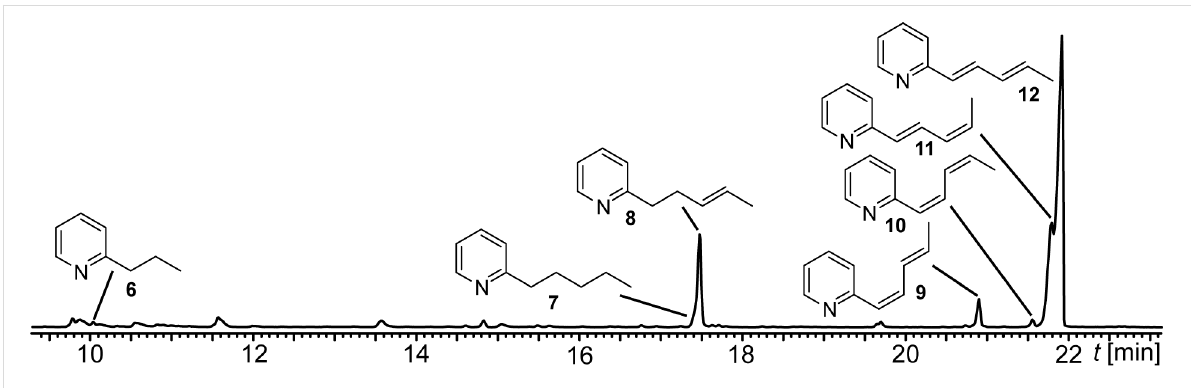
Figure 2: Part of the total ion chromatogram of the headspace extract of Streptomyces sp. FORM5 with the structures of 2-propylpyridine ( 6 ), 2-pentylpyridine ( 7 ), ( E )-2-(pent-3-en-1-yl)pyridine ( 8 ), 2-((1 Z ,3 E )-penta-1,3-dien-1-yl)pyridine ( 9 ), 2-((1 Z ,3 Z )-penta-1,3-dien-1-yl)pyridine ( 10 ), 2-((1 E ,3 Z )-penta-1,3-dien-1-yl)pyridine ( 11 ), 2-((1 E ,3 E )-penta-1,3-dien-1-yl)pyridine ( 12 ).